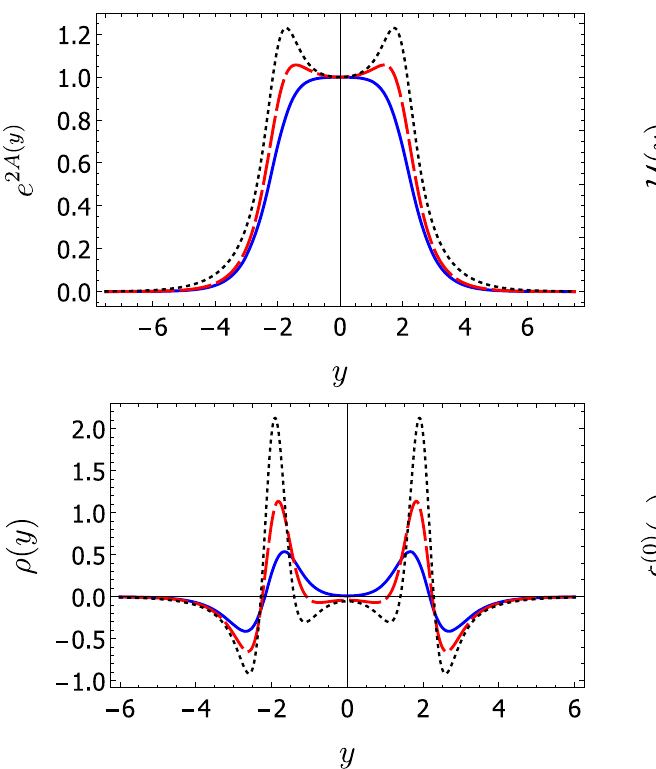
Fig. 2 Stability potential (top panel) and zero mode (bottom panel) depicted for c = 2 and α = 0 (solid-line), α = 0 . 5 (dashed-line) and α = 1